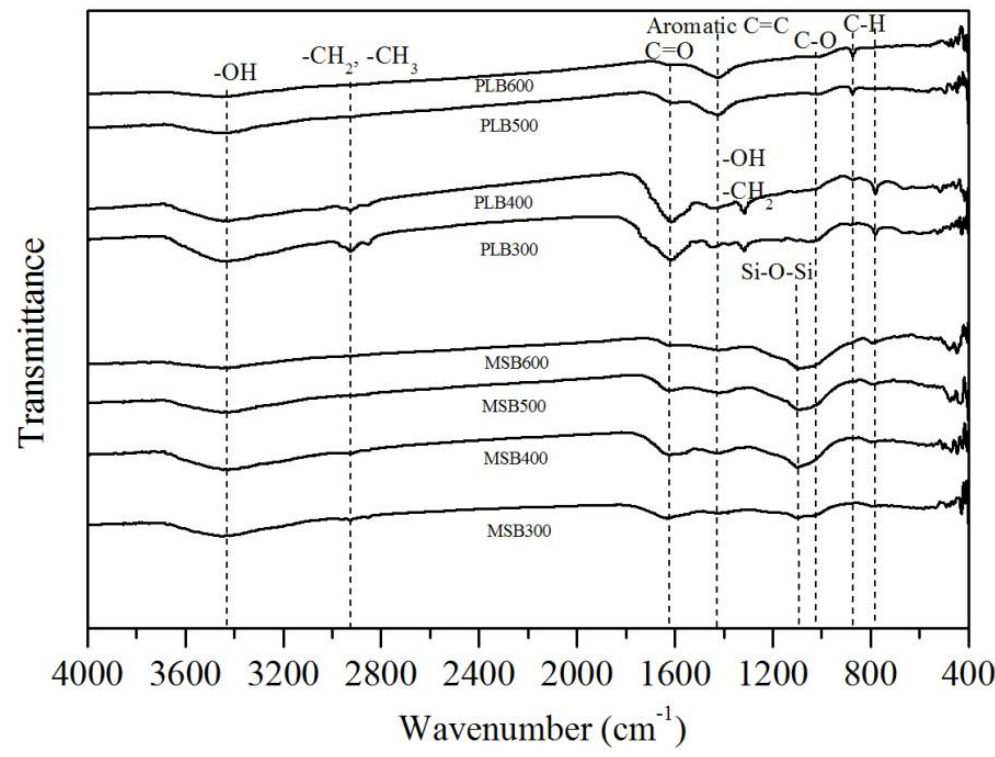
Figure 2. Fourier transform infrared (FTIR) spectra of maize straw biochars (MSB) and Platanus leaves Figure 2. FTIR spectra of MSB and PLB pyrolyzed at 300-600 °C. biochars (PLB) pyrolyzed at 300–600 ◦ C. Table 1. Physio-chemical properties of MSB and PLB pyrolyzed at 300, 400, 500 and 600 ◦ C. Elemental Composition Molar Ratio Surface Area Biochar pH Ec (mS/cm) Ca * (mg/g) Mg * (mg/g) (m 2